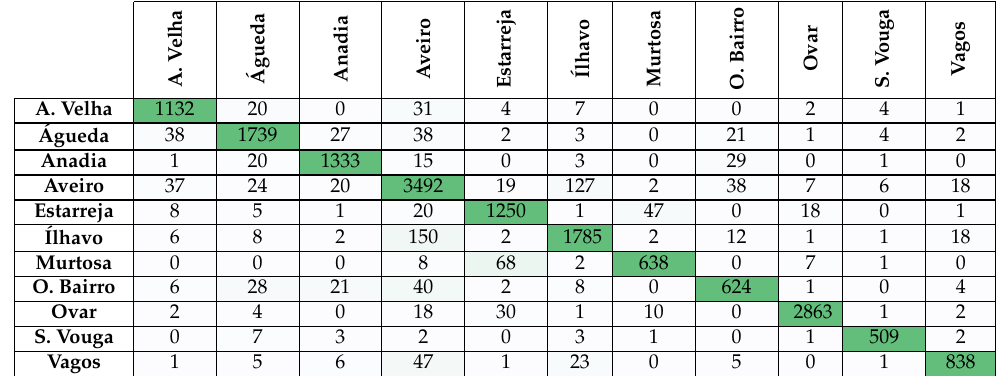
Table 2. Contact matrix regarding the data of the different municipalities between 2020 and